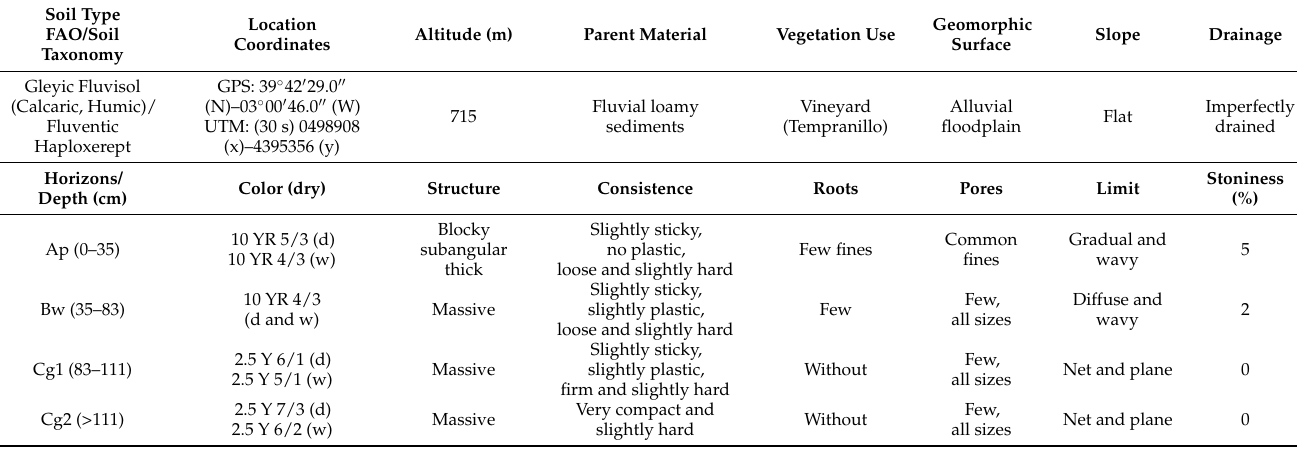
Geomorphic Surface Slope Drainage Vineyard Alluvial (Tempranillo)